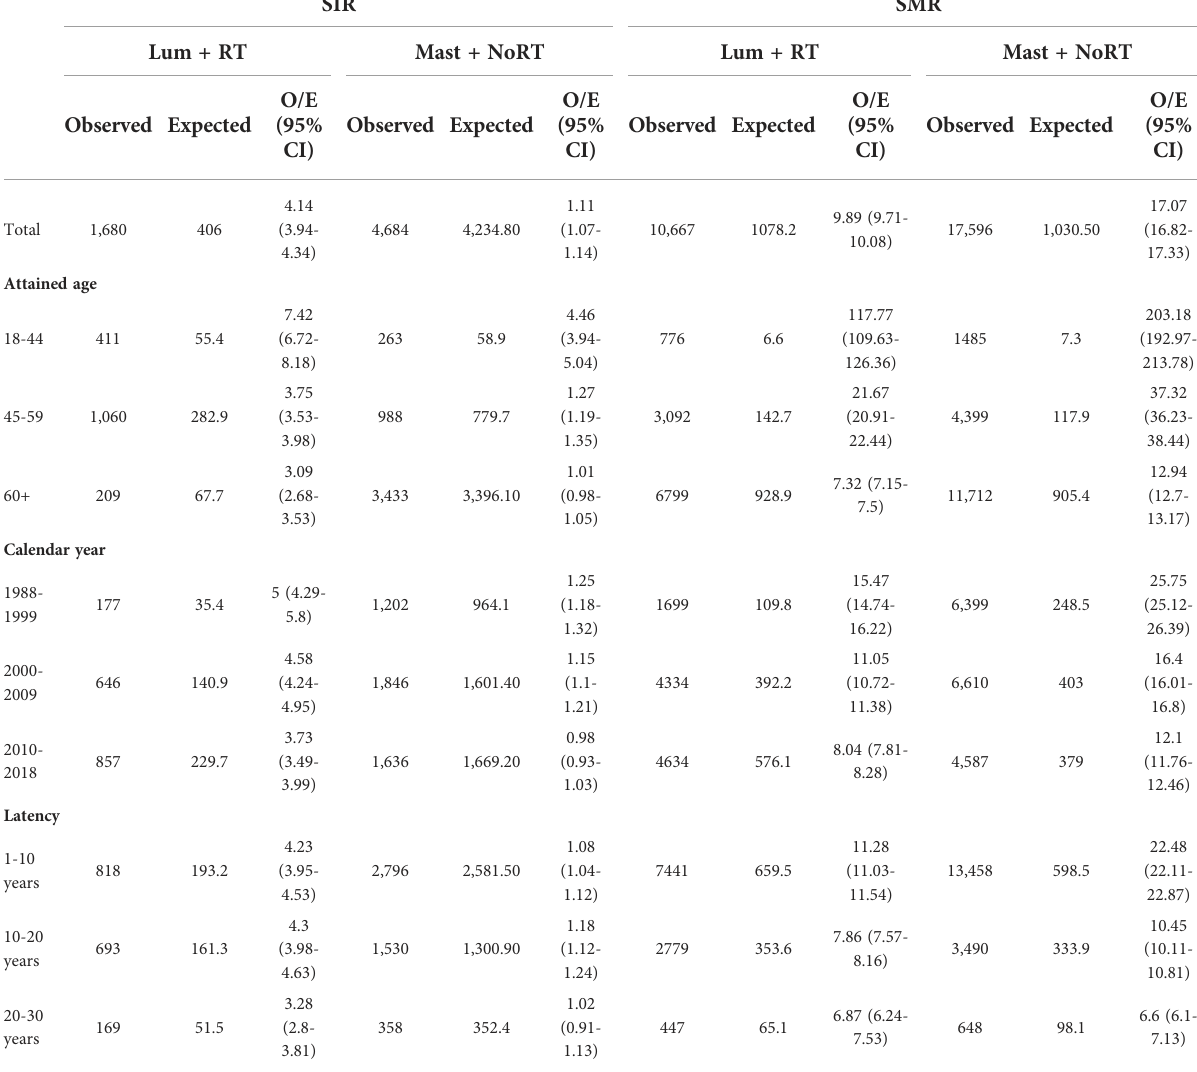
TABLE 2 Standardized incidence ratios (SIRs) for breast cancer recurrence and standardized mortality ratios (SMRs) for breast cancer-speci fi c death by